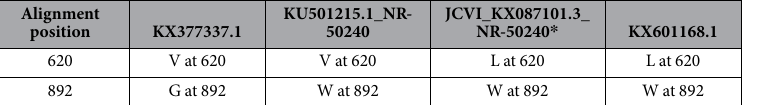
Table 4. Substitutions in the polyprotein of different PRI/PRVABC59/2015 sequences, with numbers representing the amino acid positions in the polyprotein for each sequence. * Sequenced at JCVI as part of